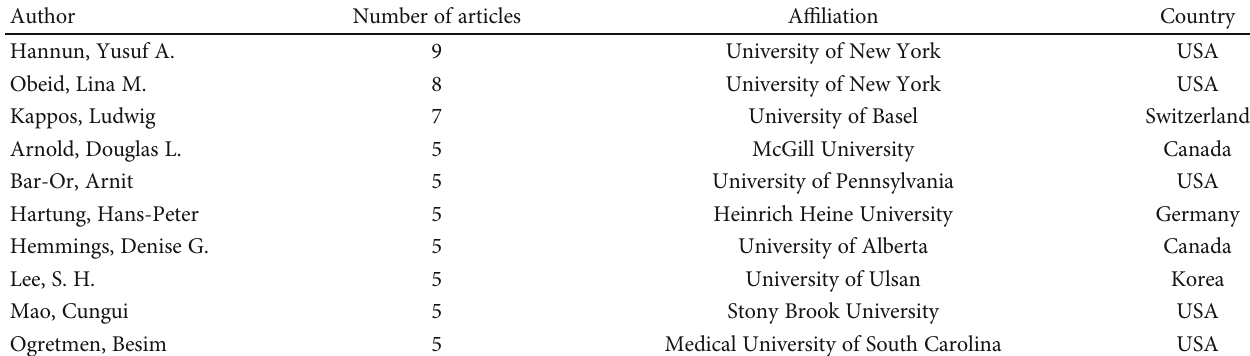
Table 4: Authors with more than 4 articles in S1P and age-related investigations.